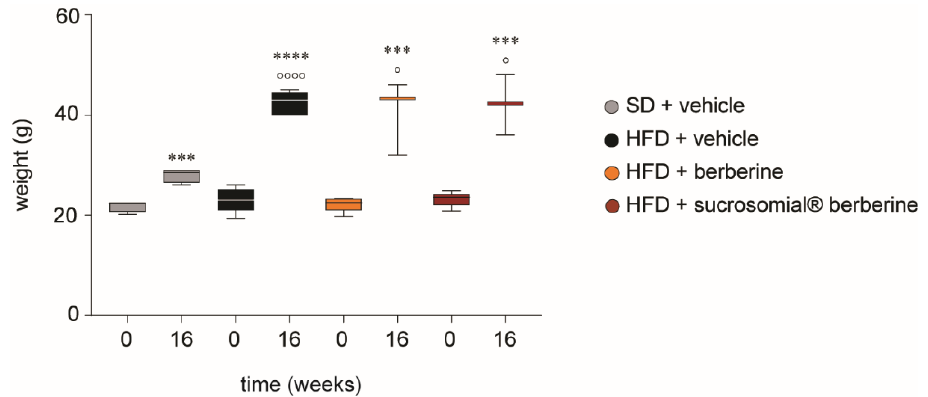
Figure 5. Effect of HFD and Sucrosomial ® berberine treatment on body weight of C57BL/6 mice during the 16 weeks of treatment. *** p < 0.001; **** p < 0.0001 vs. time 0. ° p < 0.05; °°°° p < 0.0001 vs. SD at 16 weeks.